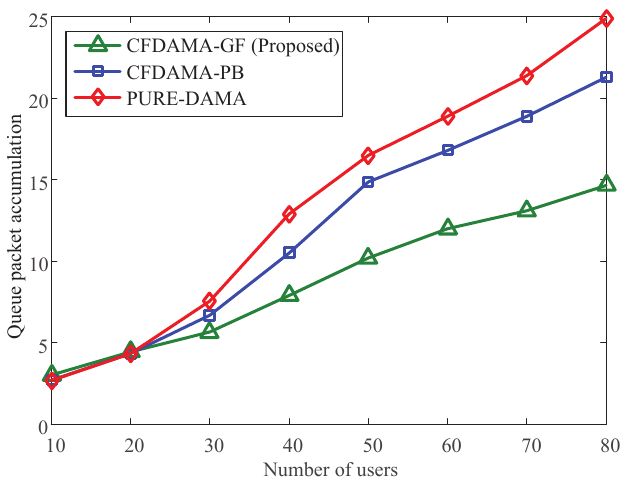
Figure 7. Comparison of the number of queued packets and the number of